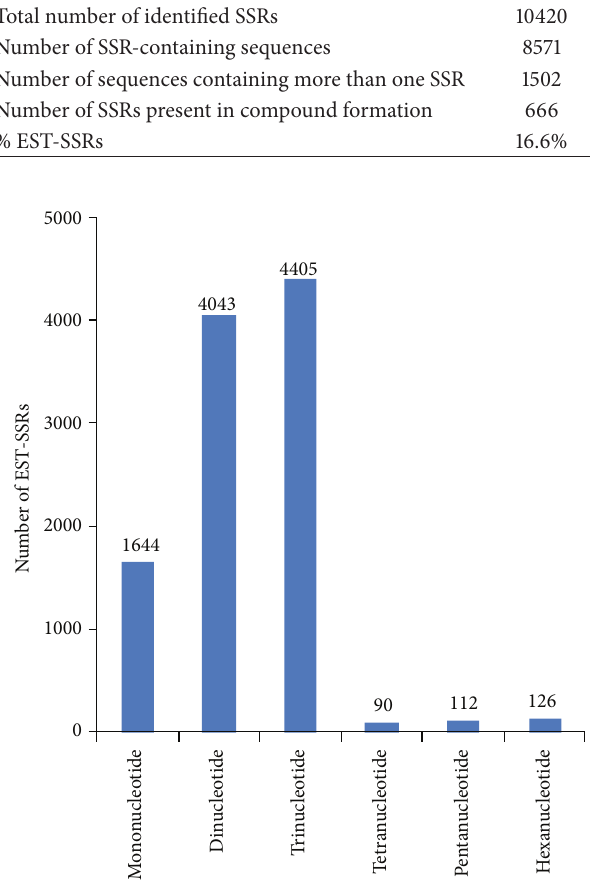
Figure 2: EST-SSR